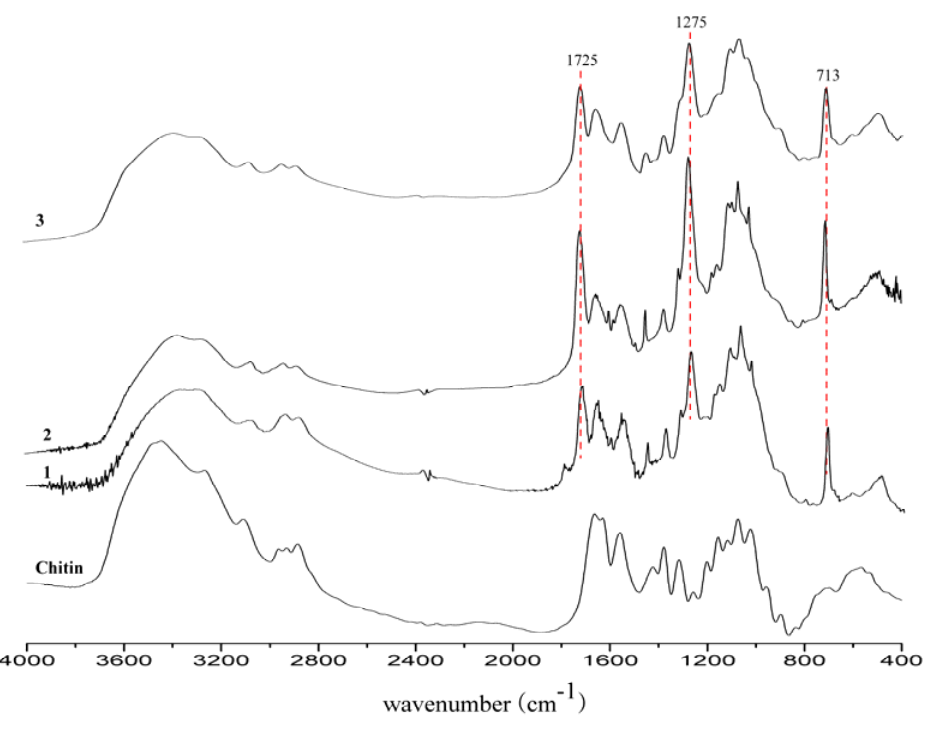
Figure 1. FT-IR spectra of chitin benzoic acid